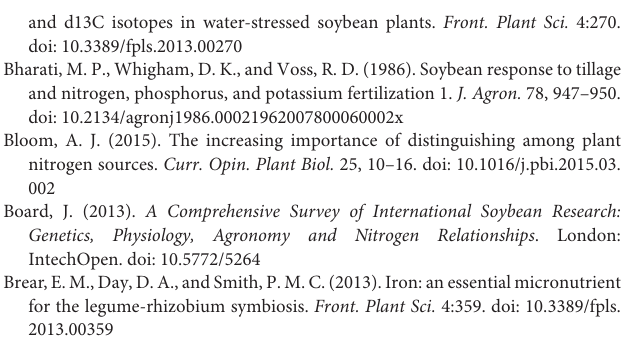
Supplementary Figure 1 | Mini-rhizobox for image acquisition. Supplementary Table 1 | Camera